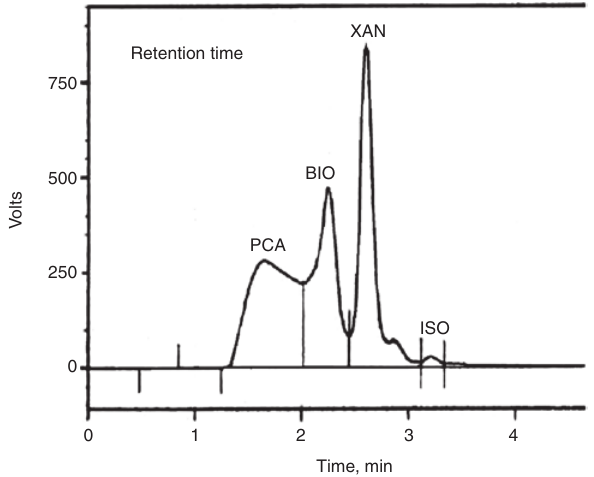
Figure 1: Detection of pteridines from whole body extraction of Anopheles stephensi .